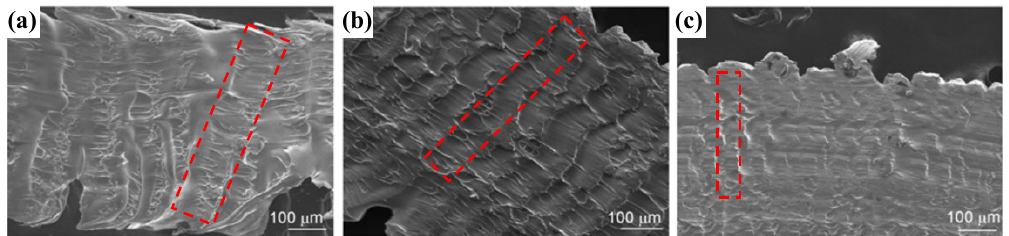
Figure 10. SEM micrographs of the underside of BMGs chips at different shear speeds: ( a ) 1.06 m/s, ( b ) 0.50 m/s and ( c ) 0.25 m/s, reprinted with permission from Ref. [82] 2011, Springer. The red mark is the degree of melting of the chip surface.